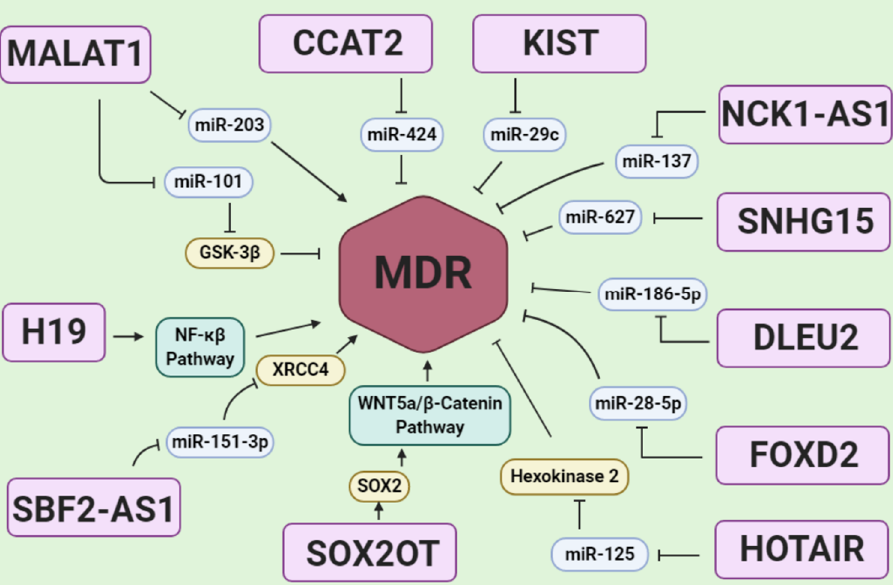
Figure 4. A scheme of lncRNAs in glioblastoma drug resistance via regulating MDR. Most of the lncRNA regulation on MDR is mediated by miRNA sponging in glioblastoma drug resistance. miRNA sponging causes MDR activation or MDR inhibition, and they may regulate via a miRNA direct sponge effect on MDR or sponging the miRNA, which is involved in targeting genes related to MDR regulation such as Sox2, XRCC4, Hexokinase 2, and GSK-3β. In addition, some lncRNAs including H19 and SOX2OT could activate signals such as NF-kB and WNT5a/β-Catenin which can activate MDR.